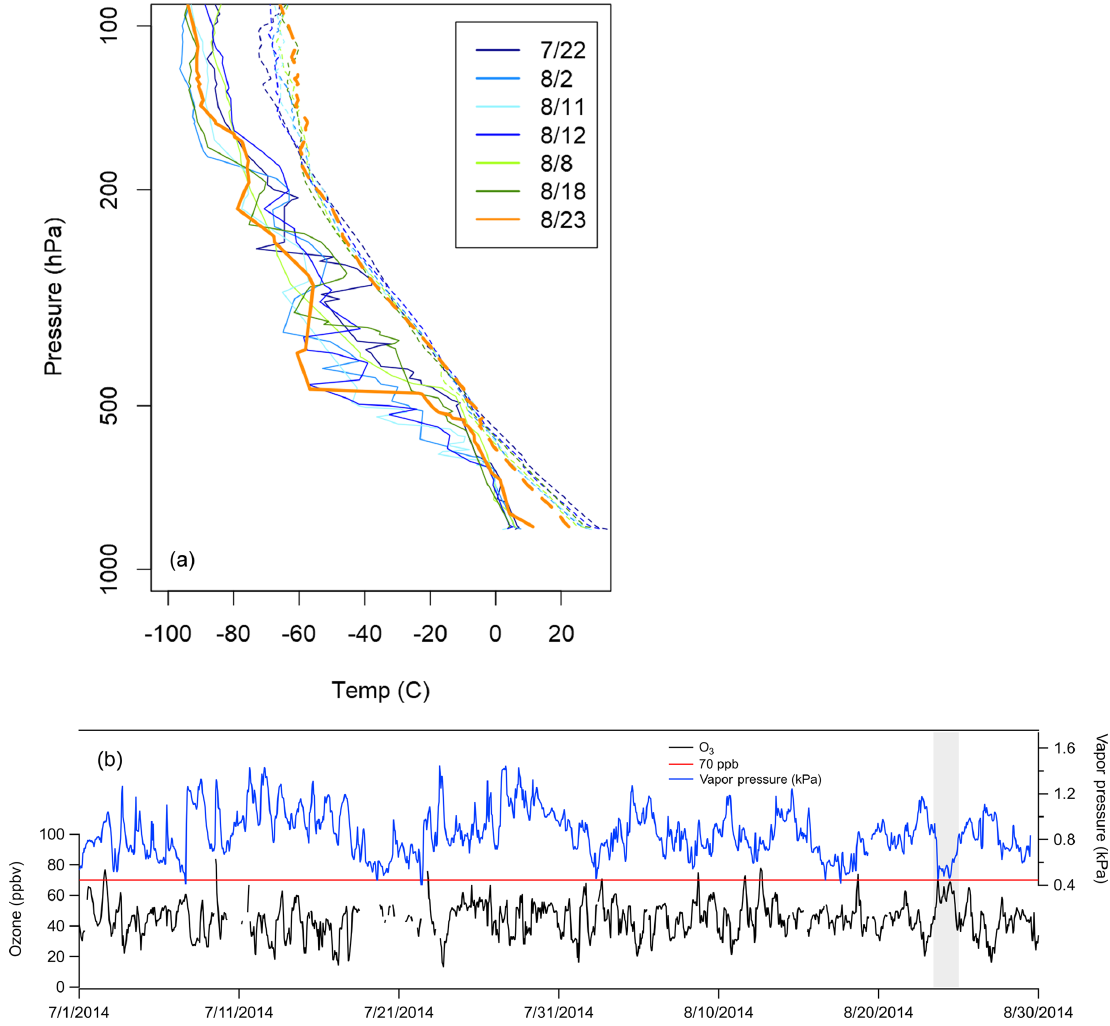
Figure 15. (a) Denver soundings (available at http://weather.uwyo.edu/upperair/sounding.html, last access: 10 May 2018) from high-O 3 days, showing surface temperature (dashed lines) and dew point (solid lines). (b) Measured O 3 concentration and water vapor at ROMO-LP during the study period. The event from 23 August is highlighted with grey